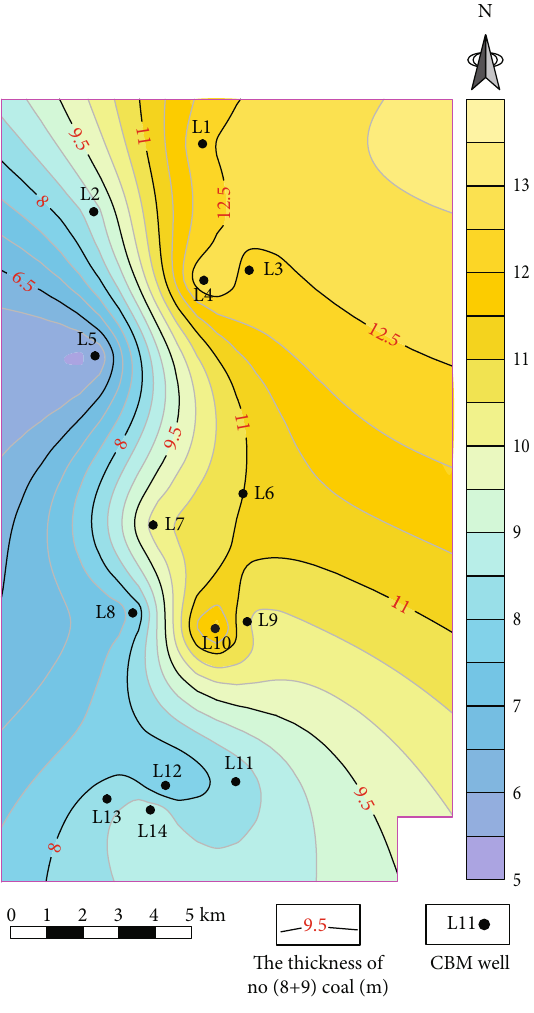
Figure 5: Contour map of burial depth of No. ( 8 + 9 ) coal in Yangjiapo